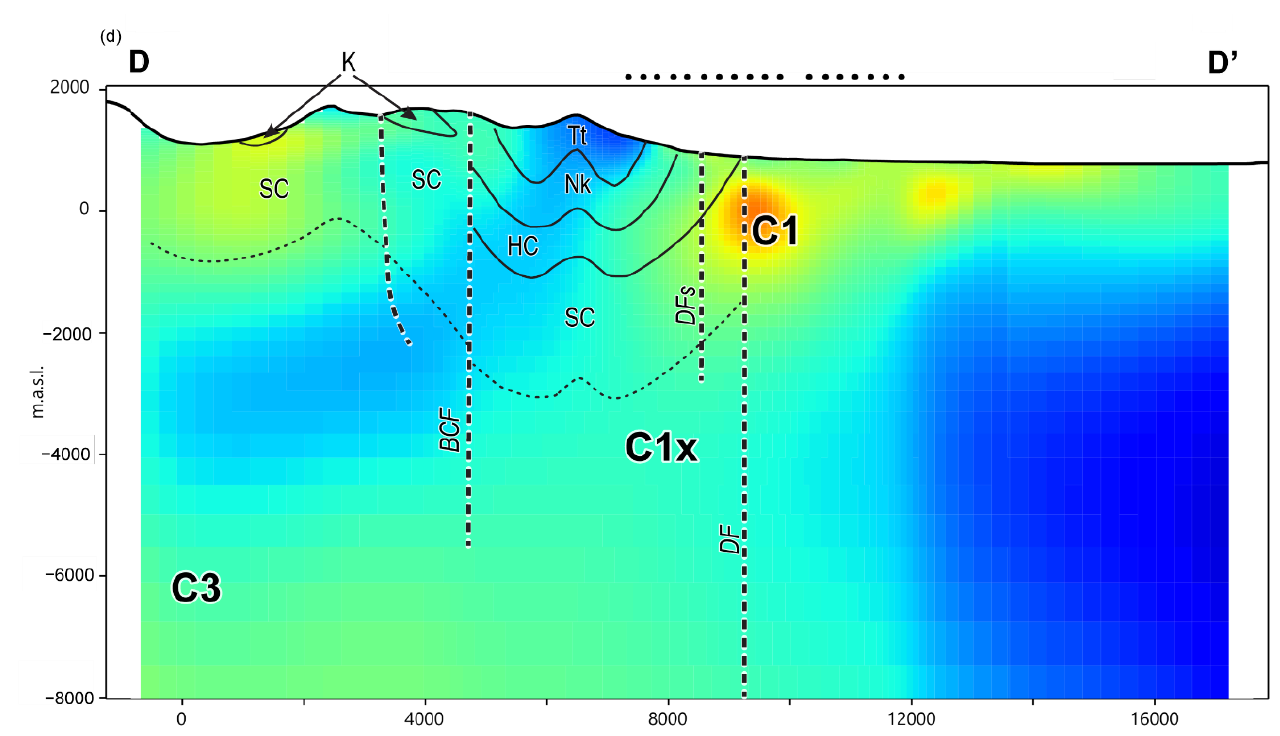
Figure 6. Cross-sections through the preferred 3D resistivity model. Locations of cross-sections ( a ) in Figure 2. Red circle in ( b ) as discussed in text. Vertical exaggeration = 1. Color bar as in Figure 5.